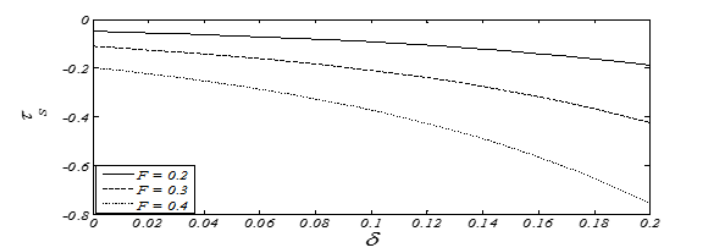
Fig. 15 Shear stress at stenotic throat for